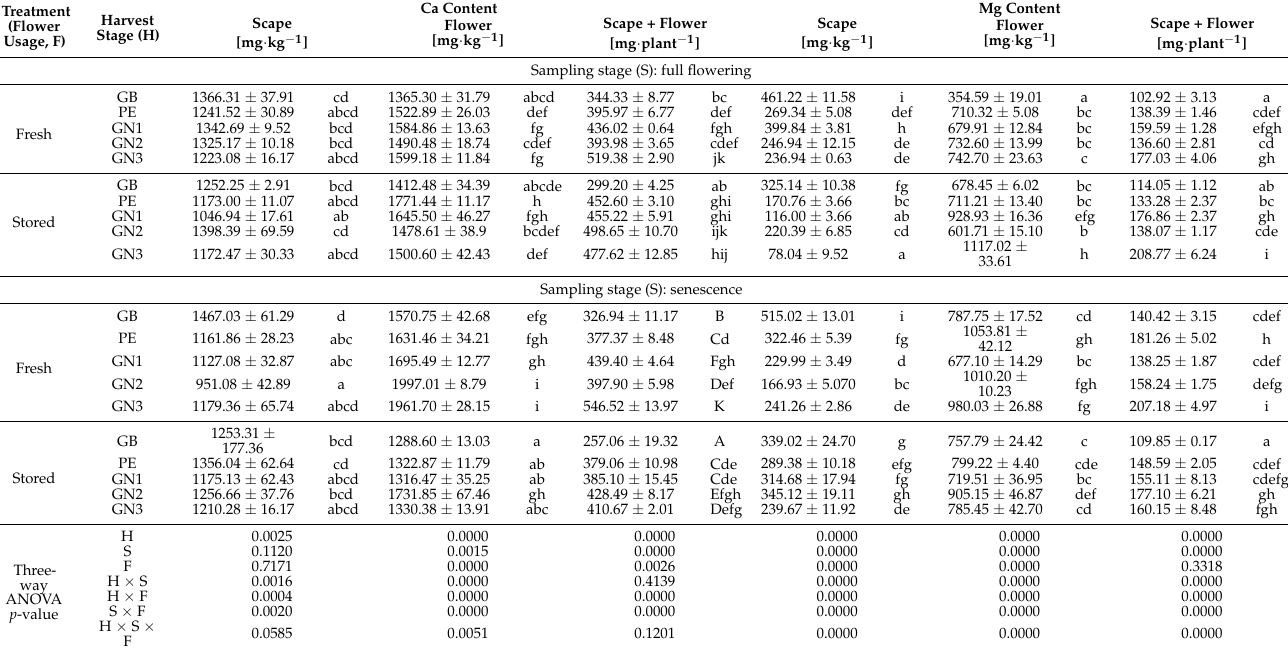
Table 5. Calcium and magnesium content of plant